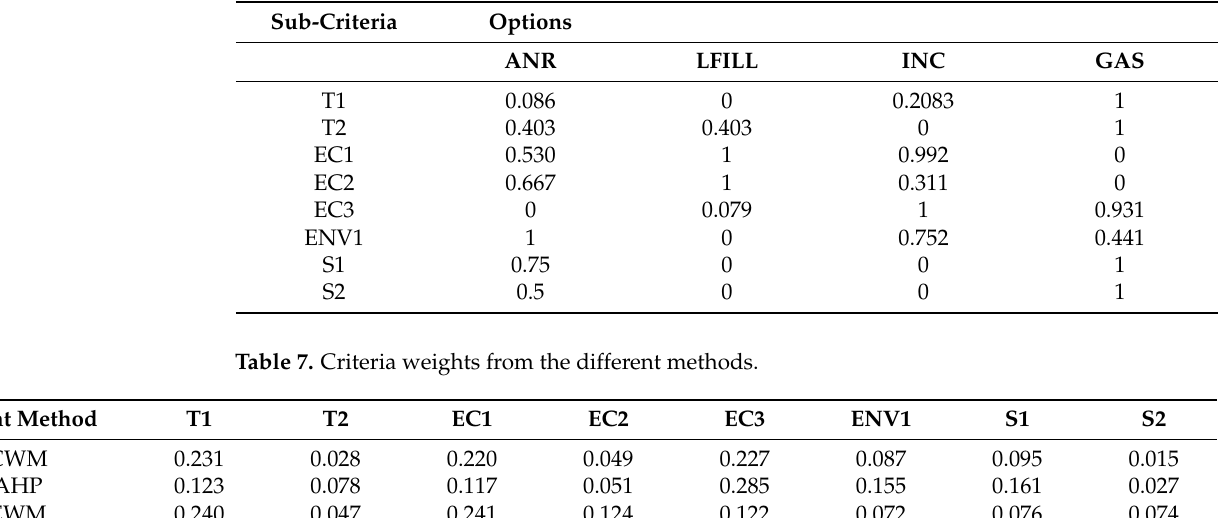
Table 6. Normalized decision matrix.